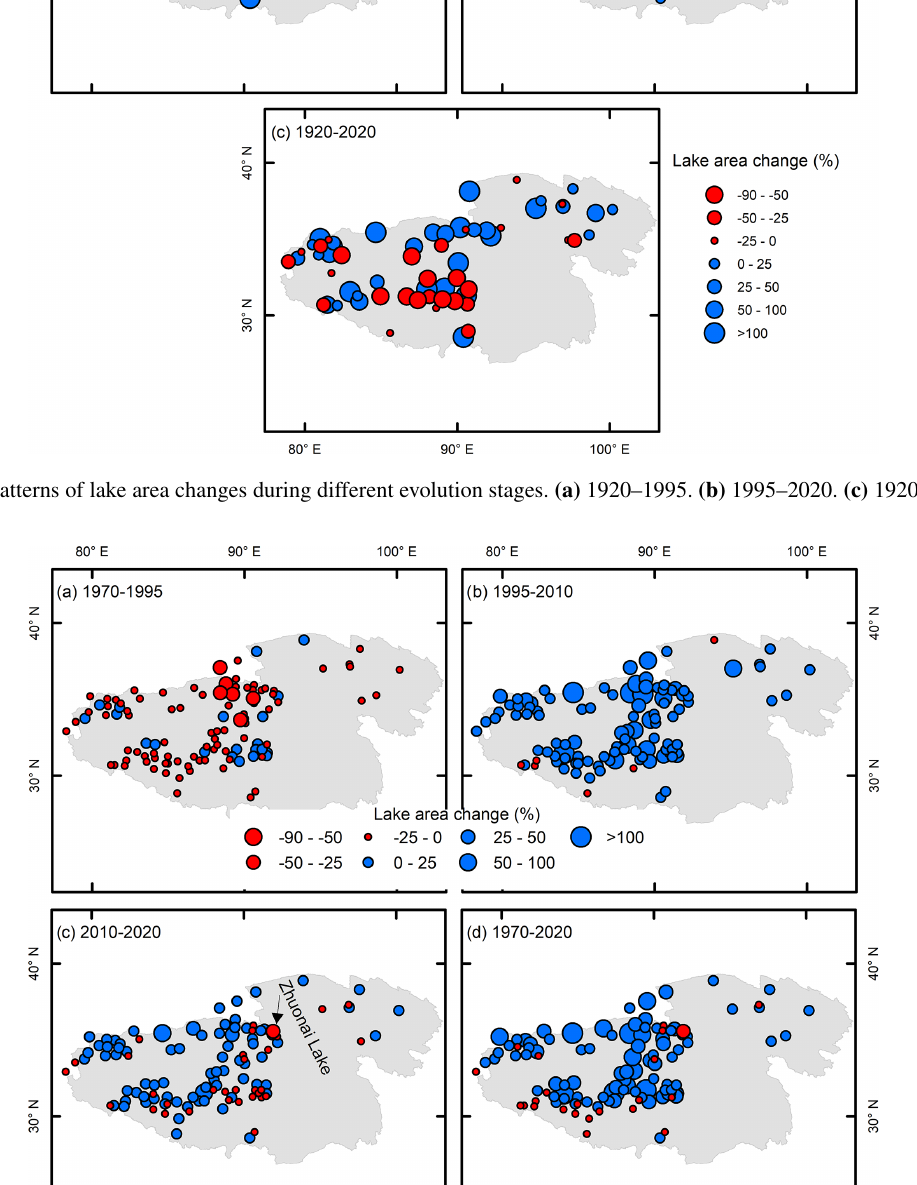
https://doi.org/10.5194/essd-13-3951-2021 Earth Syst. Sci. Data, 13, 3951–3966,